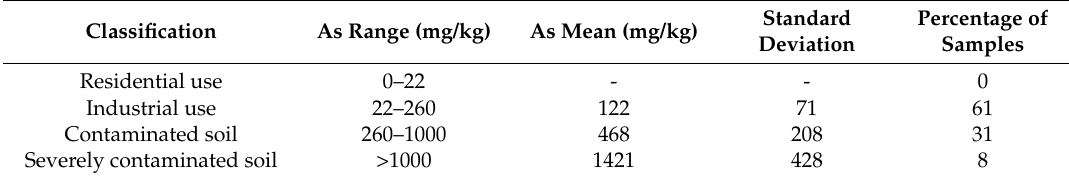
Table 2. Soil classification by arsenic